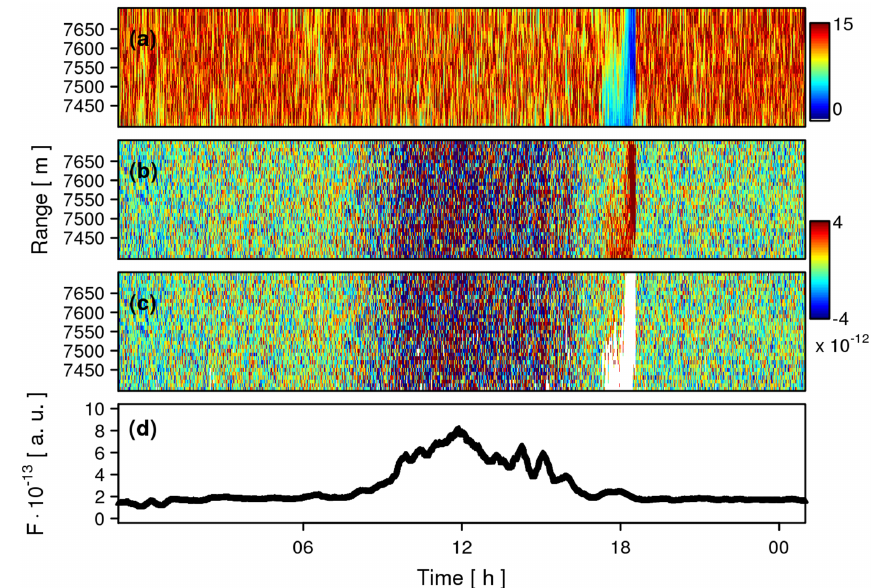
Figure 8. Observations from Vaisala CL31 sensor D (Table 2) at top range gates (7410–7700m) with cirrus during the early evening on 1 February 2013: (a) relative variance RV (Eq. 14); (b) background-corrected signal ˆ P ; (c) same as (b) but only including observations with RV>1; and (d) time series of the noise floor F (Eq. 13) based on the cleaned signal shown in (c) with missing values interpolated linearly.